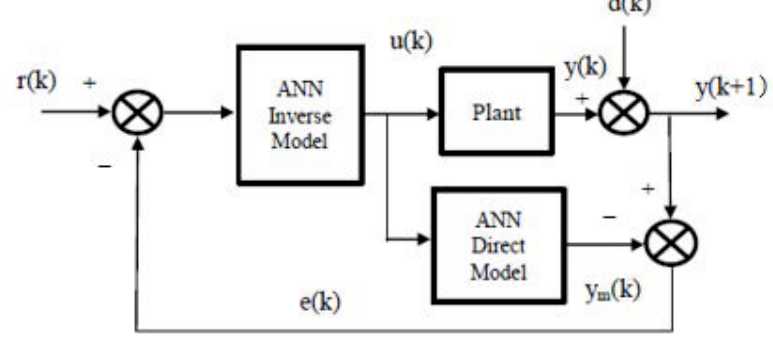
Figure 10. Conventional IMC (C-IMC) Neural Network block diagram .